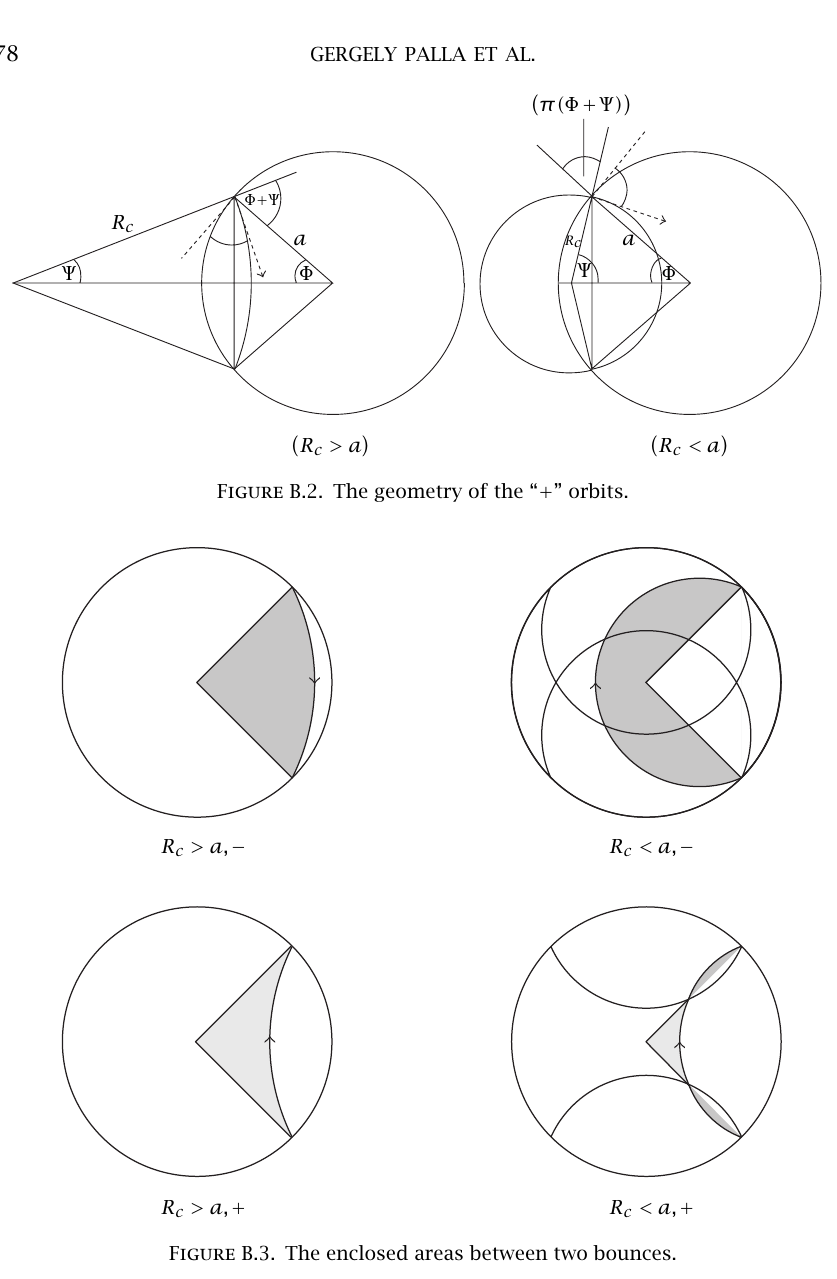
Figure B.3 . The enclosed areas between two